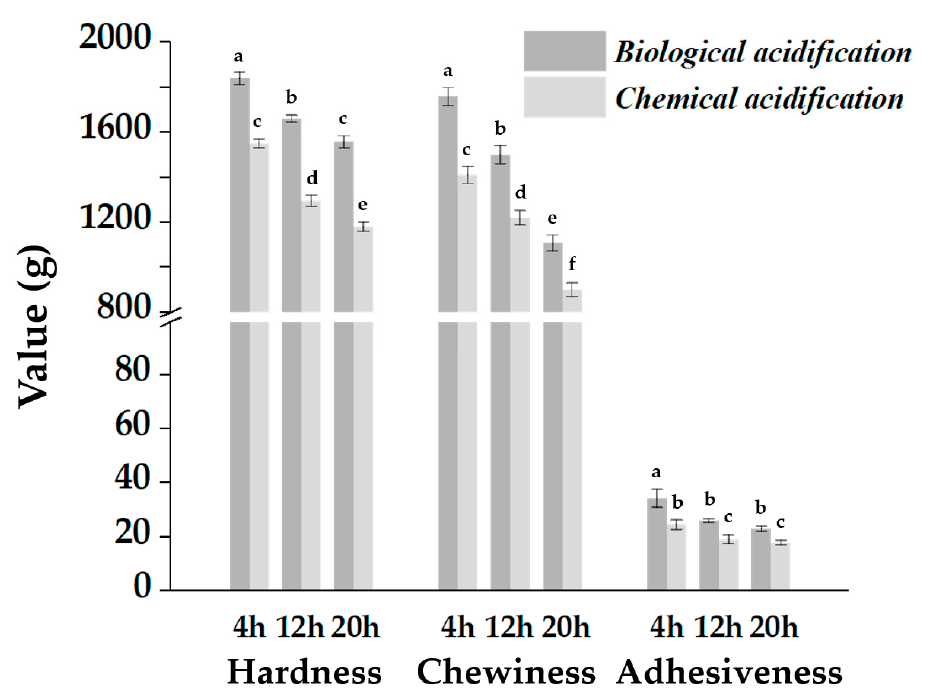
Figure 5. Texture of Chinese steamed bread with different acidification methods. Data are presented as means ± standard error of the mean.